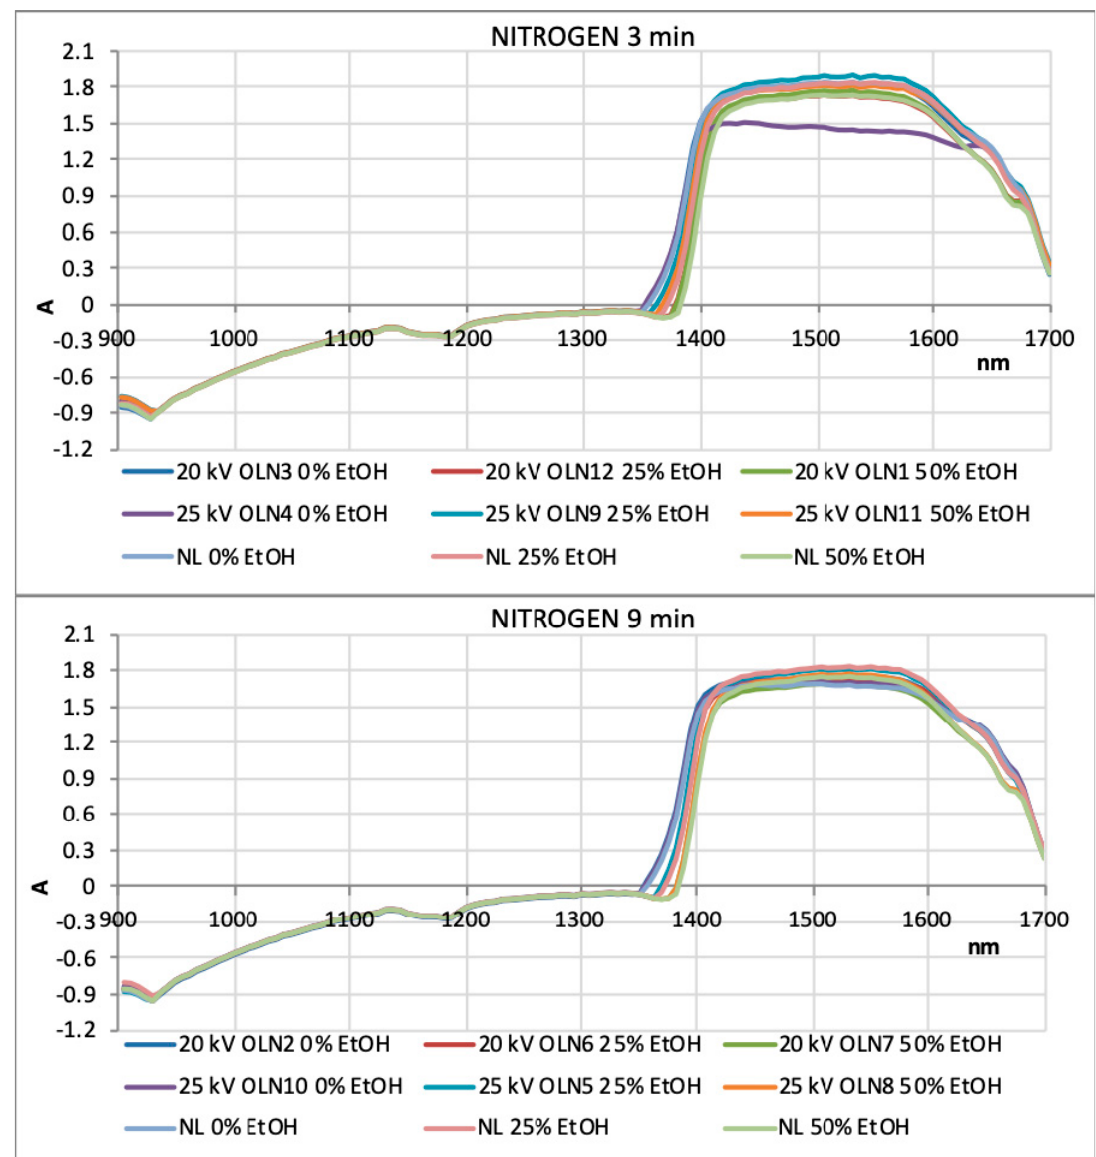
Figure 6. NIR spectra recorded in the wavelength range of 904 nm to 1699 nm for OLEs treated with nitrogen for 3 min and 9 min (NL: untreated olive leaves).